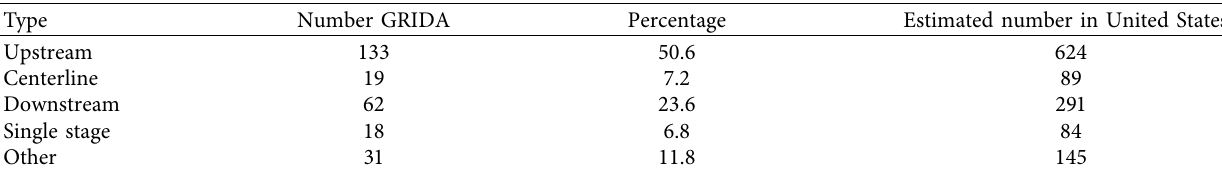
Figure 6: Percentage of tailings dams failed per tailings dams built in the United States, before and after 2000, according to dam type (data from GRID-Arendal [25] and Bowker [22]). Table 3: Estimation of United States tailings dams by